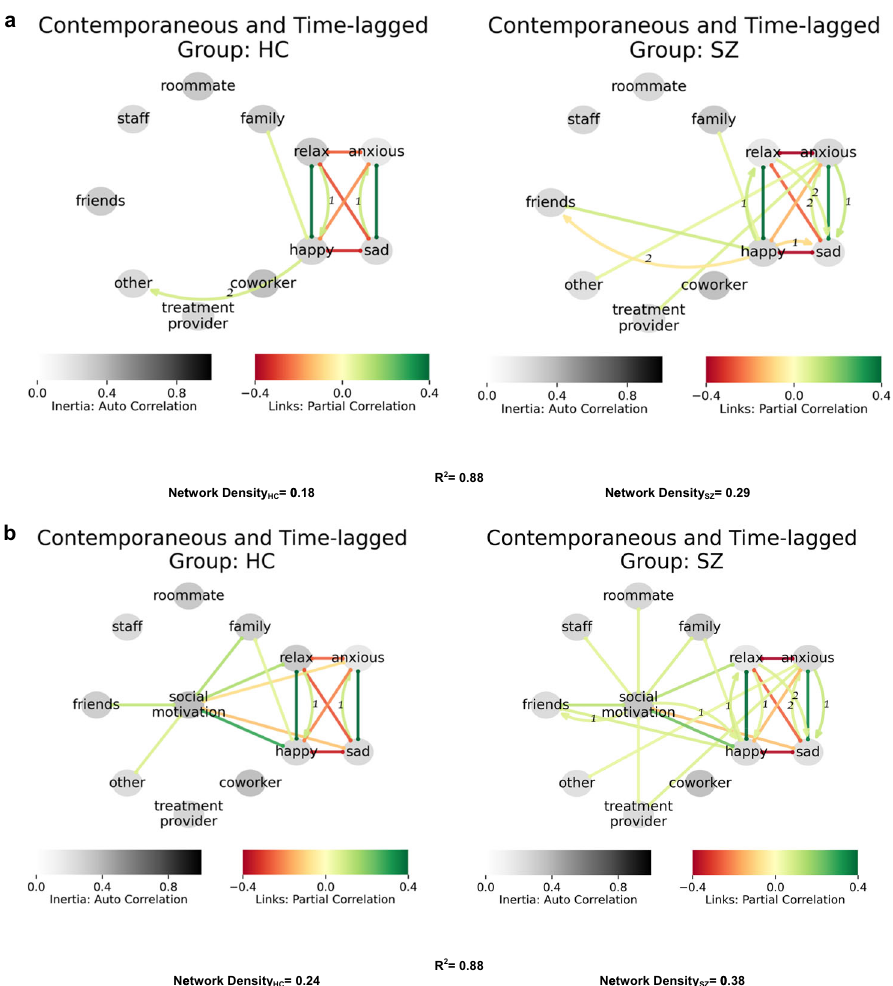
Fig. 3 Interaction partners, affect, and motivation. a SZ networks of interaction partners, and affect were denser in the SZ group compared to HC. Link between interaction with others and happy is lacking in SZ, while strong link to anxiousness is evident. b Social motivation translates to interaction with other in HC but not SZ. Further, social motivation in SZ is highly connected (node centrality) and hence an excellent suggested candidate for intervention. Treatment providers are often associated with both motivation and anxiety in